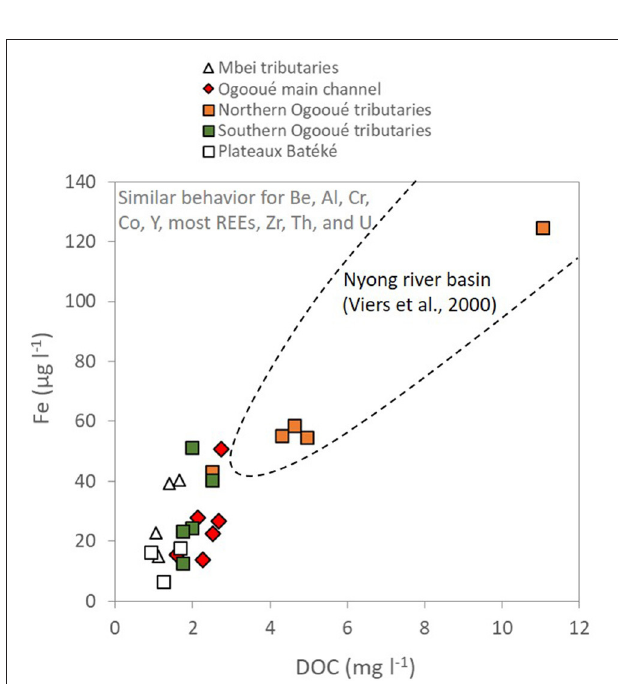
FIGURE 7 | Global average-normalized patterns for the river dissolved load of the Ogooué and Mbei rivers. Plain lines correspond to individual samples, whereas lines with a symbol correspond to average values for each domain defined in Table 1 . Global river averages are from Gaillardet et al. (2014) for trace elements and from Meybeck (2003) for Na + , K + , Mg 2 + , and Ca 2 + . Elements are ordered along the y-axis from the highest to lowest values recorded in the Ogooué main channel.